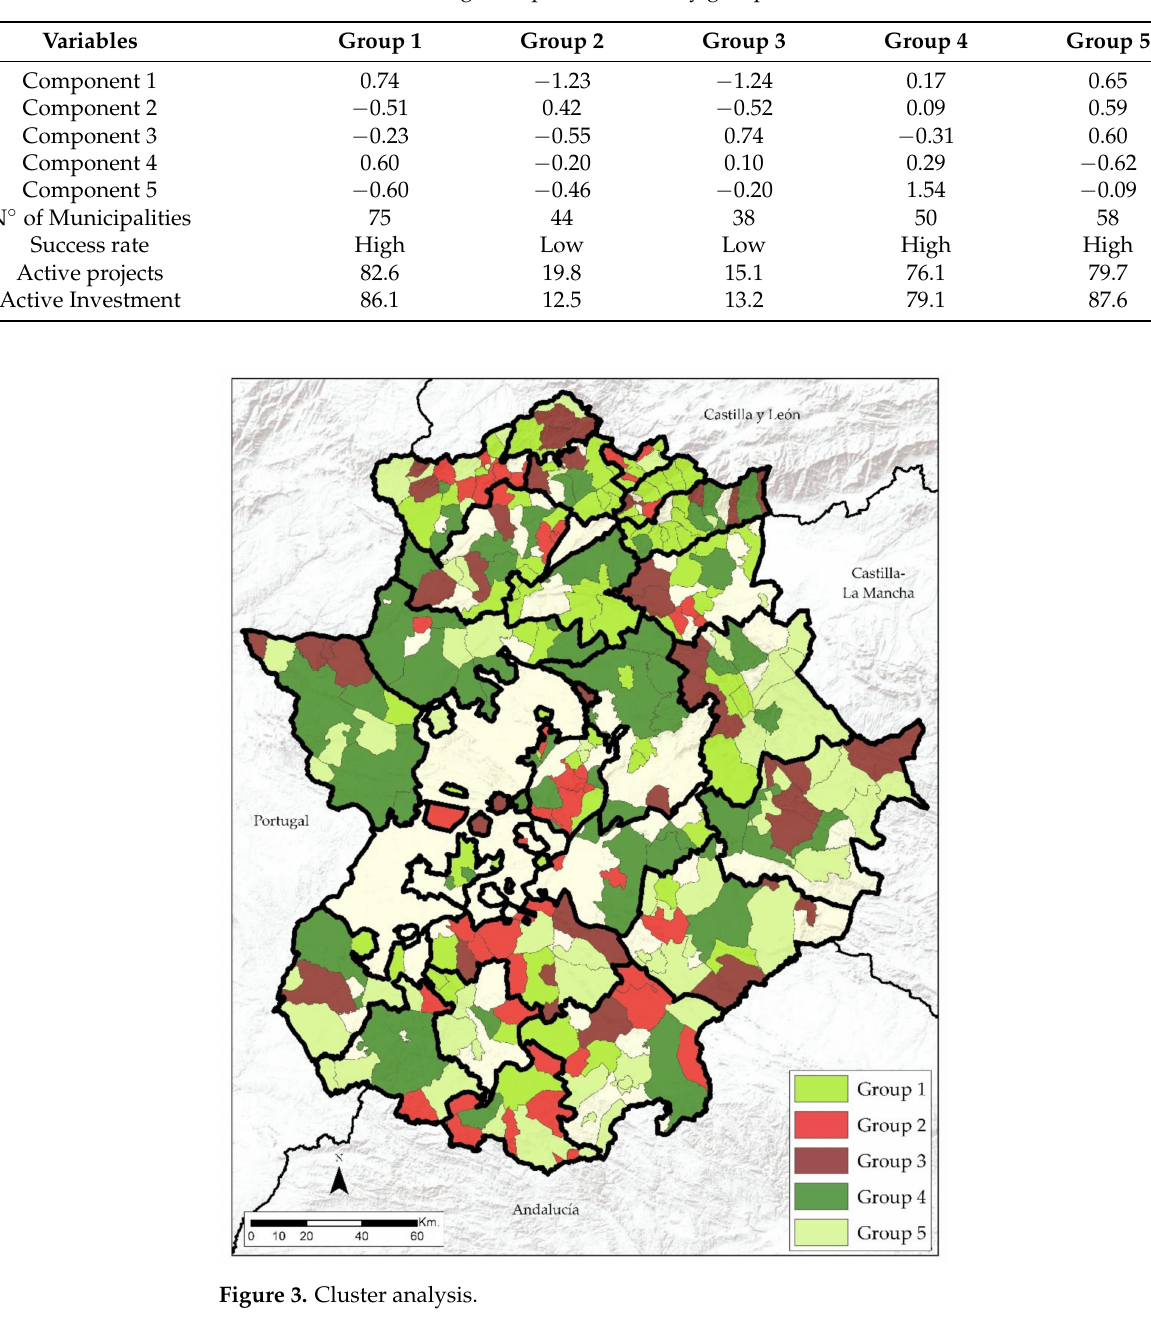
Table 6. Average component values by group.